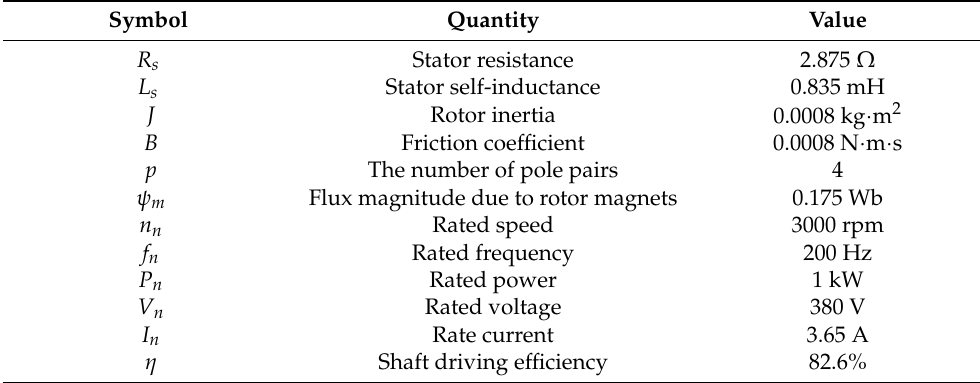
Table 1. Main parameters of PMSM.